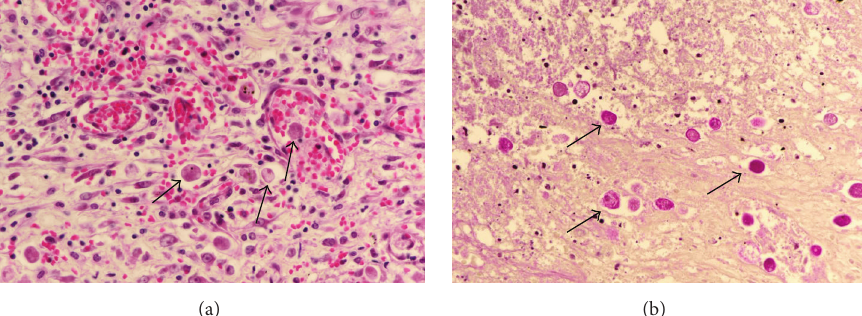
Figure 5: Histopathology ( × 400). Infiltration of ameba in the colon. Arrow shows ameba. (a) Hematoxylin and eosin staining. (b) Periodic acid-Schiff